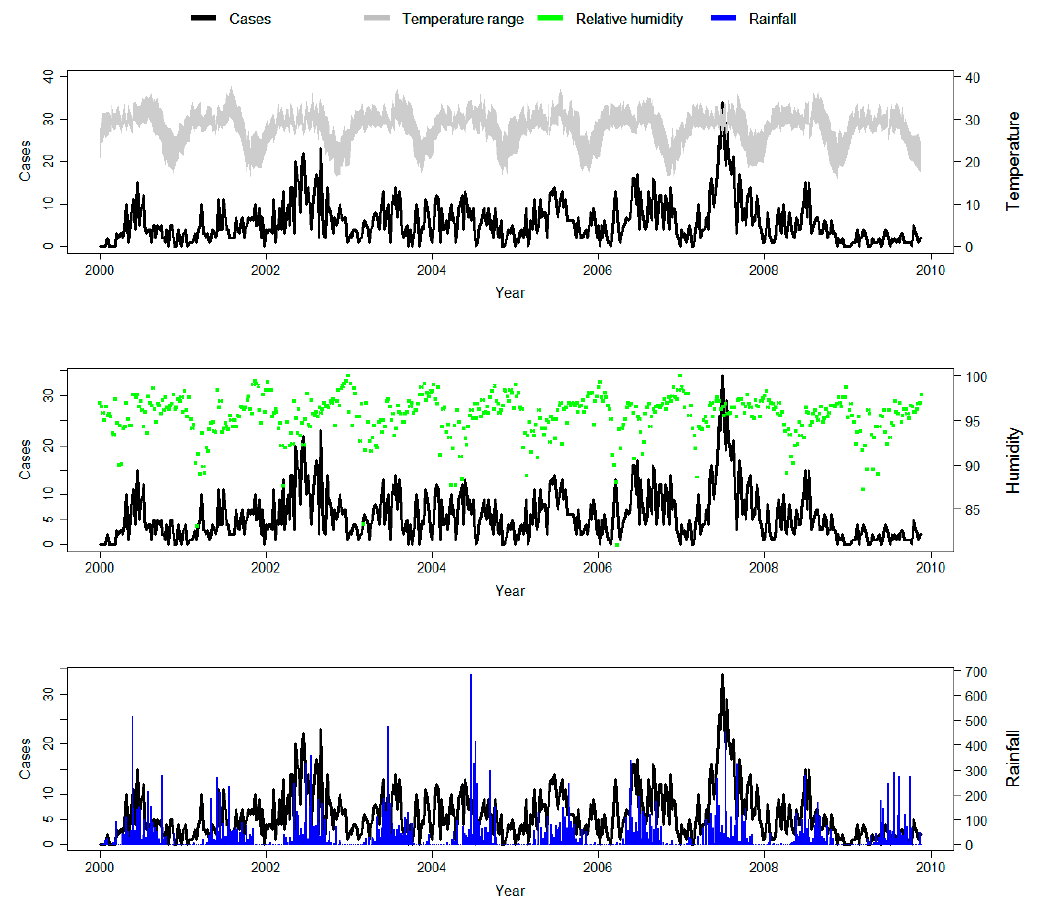
Figure 2. Time-series plots of weekly malaria cases, temperature range (weekly maximum to minimum), humidity, and rainfall in the study area.